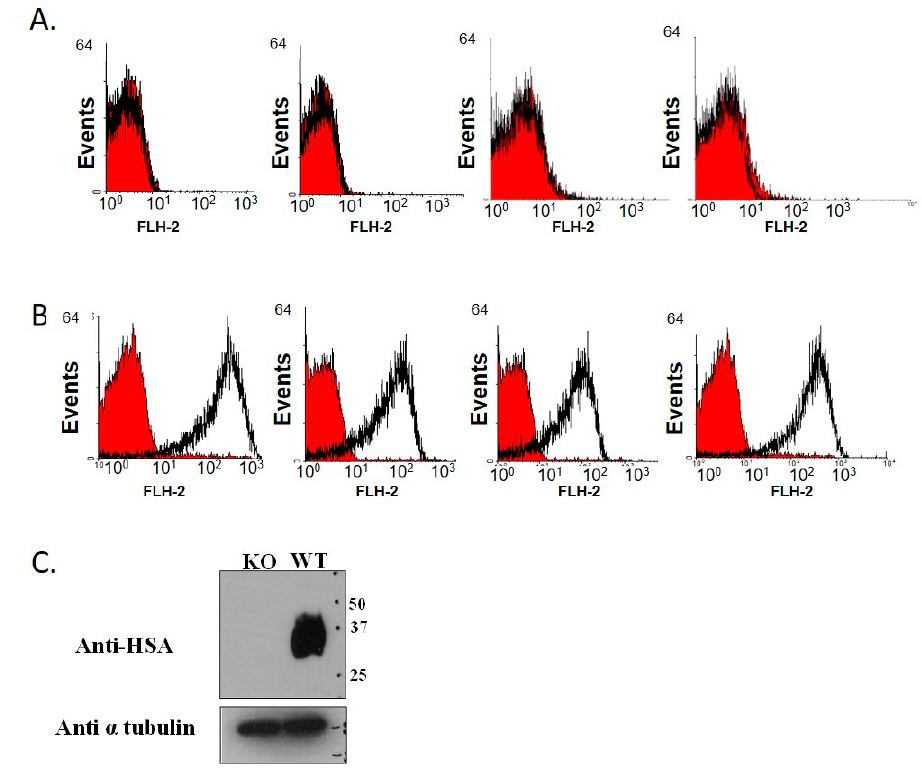
Figure 1. Genotype verification by FACS analysis. Heparinized blood samples from KO ( A ) and WT ( B ) mice were collected and analyzed for CD24 expression by FACS analysis. The red curves represent the negative control (secondary antibody only), and the black curves represent the binding of M1/69 anti-CD24 antibody. ( C ) Blood samples were taken from KO and WT mice and peripheral blood leukocytes were isolated. Protein extracts (20 µ g) were subjected to SDS-PAGE (odium dodecyl sulphate–polyacrylamide gel electrophoresis) and Western blotting using anti-CD24 M1/69 monoclonal antibodies. The membrane was re-probed with anti-tubulin to confirm uniform loading of the